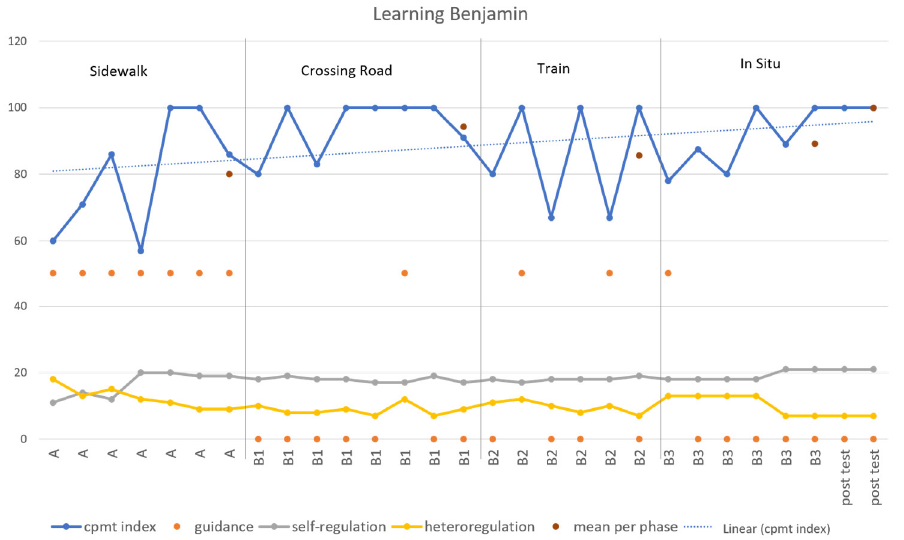
Figure 6. Learning graph—visual analysis of SCP.